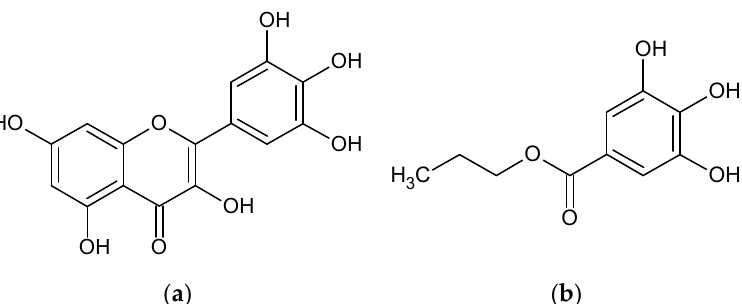
Figure 1. Comparison between chemical structures of myricetin from papaya fruit ( a ) and the standard compound propyl gallate ( b ).